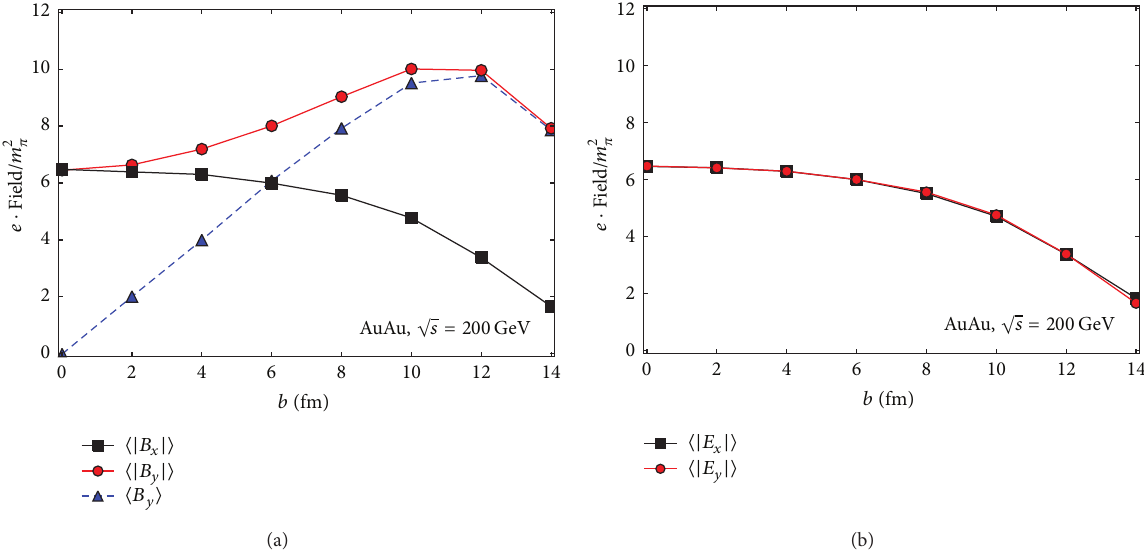
Figure 3: The mean absolute value of (a) magnetic field and (b) electric field at 𝑡 = 0 and r = 0 as a function of impact parameter 𝑏 for AuAu collision at √𝑠 𝑁𝑁 = 200